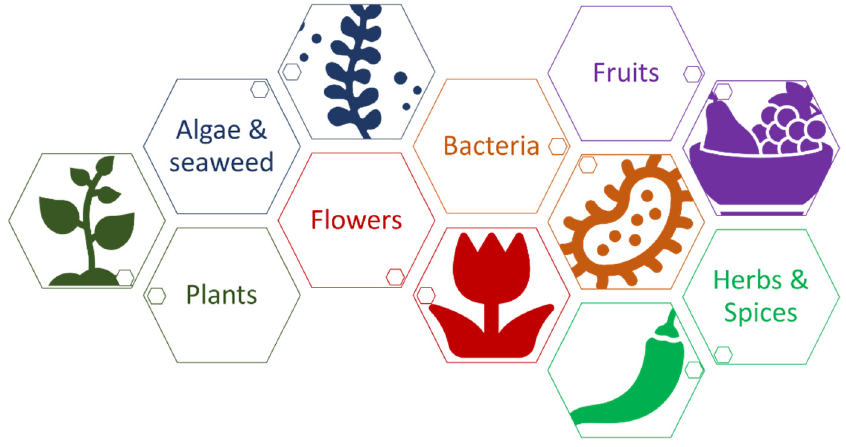
Figure 2. Most used source for reactants exploited in the biogenic synthesis of ZnONPs.